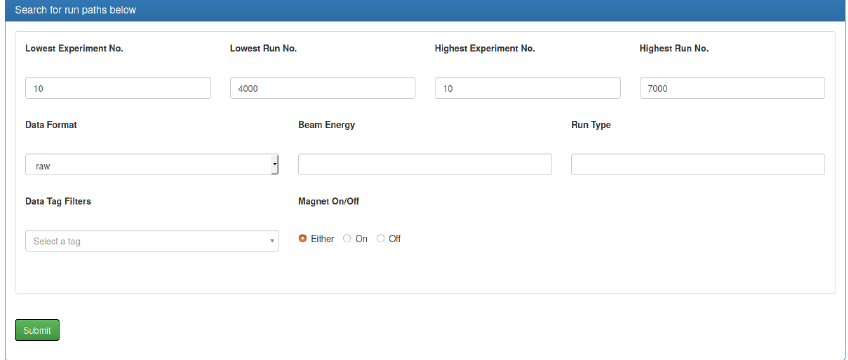
Figure 3. An example web form used to search for calibration input data. Multiple options and data tags can be selected to query for exactly the data required. For calibrations that require multiple categories of input data a web form like this is generated for each one. This allows for independent filtering of input data for each